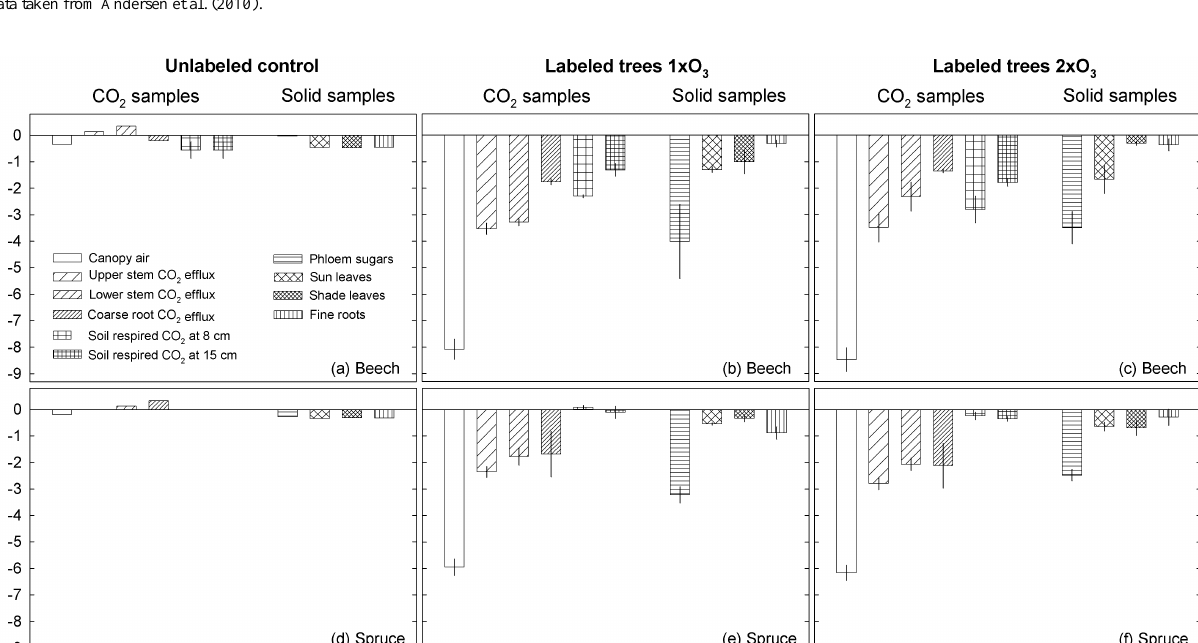
(Matyssek, 1986; Garten and Taylor, 1992; Diefendorf et al.,